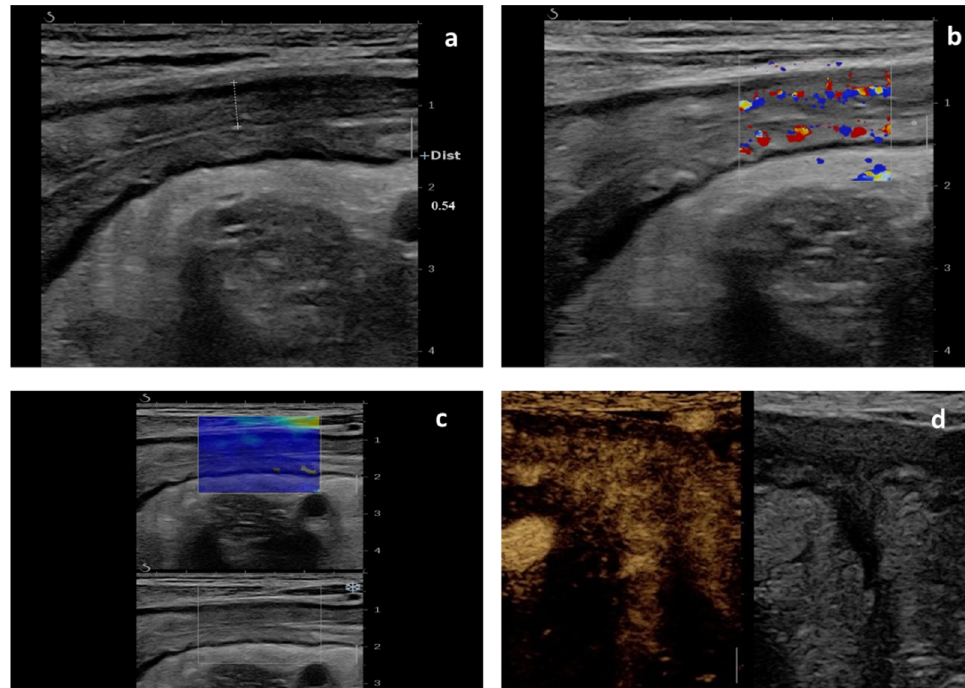
Figure 1. Multiparametric ultrasound evaluation in a 35-year-old man with ileal Crohn’s disease before starting biologic therapy. ( a ) B-mode ultrasound view of the terminal ileum shows thickened bowel wall (5.4 mm) with wall layer preservation. ( b ) Color Doppler images of the affected segment shows profuse mural blood flow (Limberg score 3). ( c ) Shear wave elastography of the affected segment providing a measure of tissue stiffness based on a colorimetric scale (blue is indicative of soft tissue). ( d ) Dual-screen ultrasound representation of the affected bowel, with gray-scale image ( right ) and contrast-enhanced ultrasound (CEUS) image of matching segment ( left ). CEUS image shows transmural